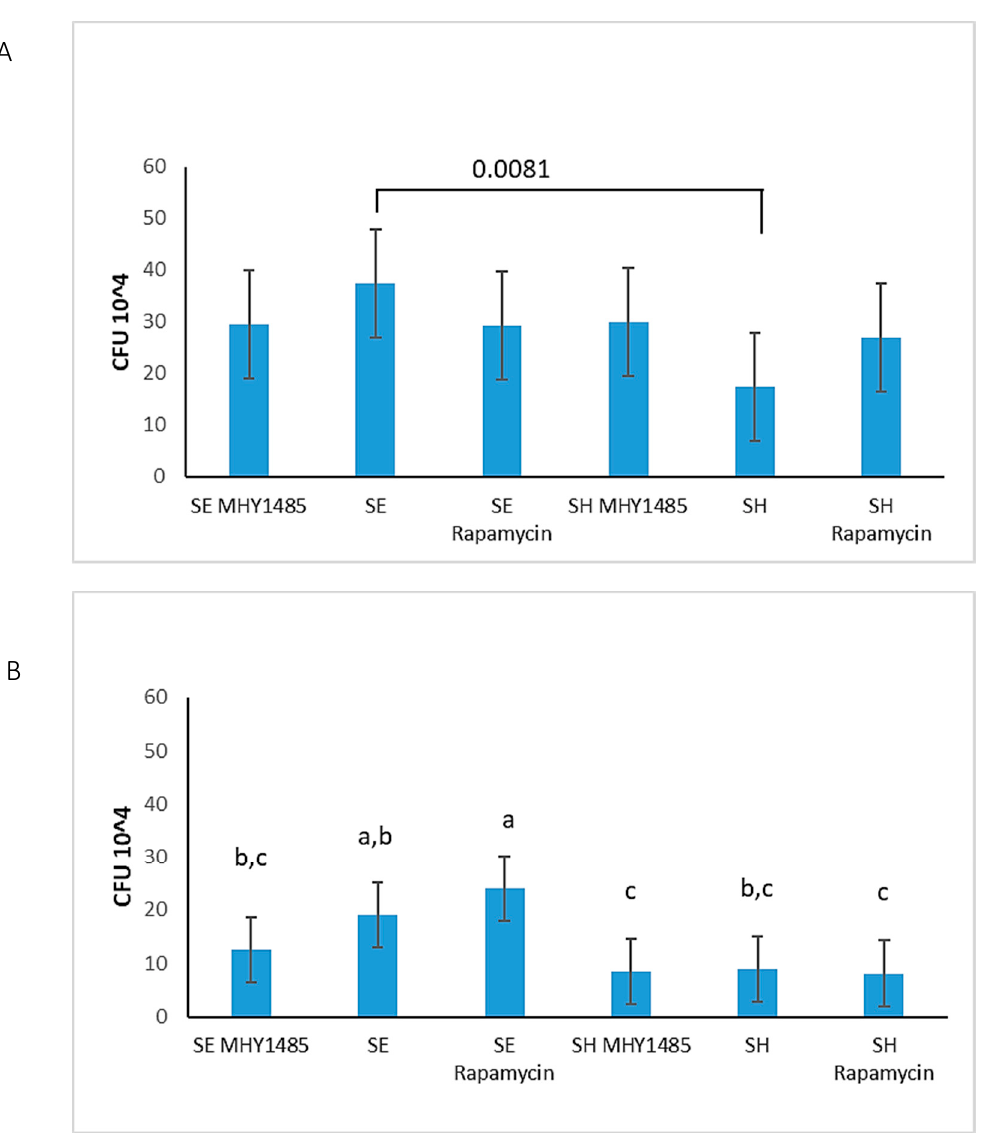
Figure 2. Invasiveness of S. Enteritidis (SE) and S. Heidelberg (SH) in HD11 macrophages at ( A ) 30 min postinfection and ( B ) 2 h postinfection. Each bar in this graph represents the average colony count or colony-forming units (CFUs) of respective serovars of Salmonella that infected HD11 cells treated with or without MHY1485 or rapamycin before 30 min gentamicin protection assay as shown in ( A ) ( p -value indicated on graph) or before 1 h gentamicin protection assay as shown in ( B ). p ≤ 0.05 observed using ANOVA and Tukey–Kramer statistical tests. Bars not connected by the same letter are significantly di ff erent. p ≤ 0.05 observed using ANOVA and Tukey–Kramer statistical tests. Ctrl, Control; SE, S. Enteritidis; SH, S. Heidelberg.